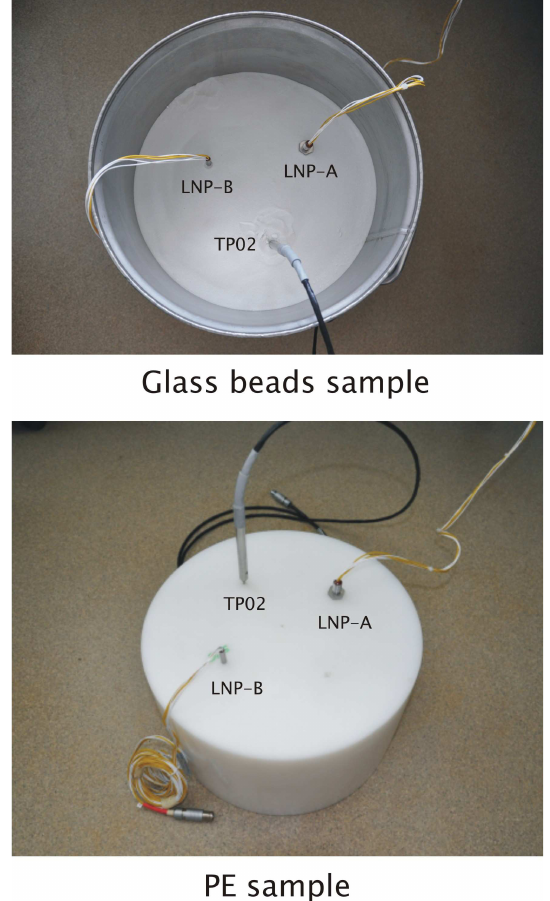
Fig. 3. Experimental setup used for the calibration measurements. Top: sensors inserted into glass beads sample; bottom sensors inserted into PE sample.